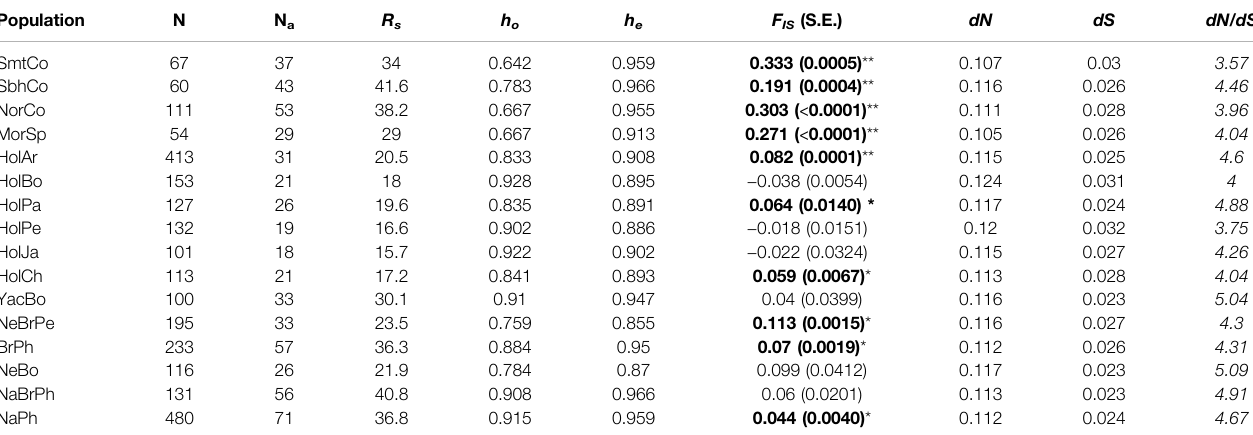
TABLE 3 | Genetic diversity estimates and Hardy-Weinberg equilibrium within cattle populations.